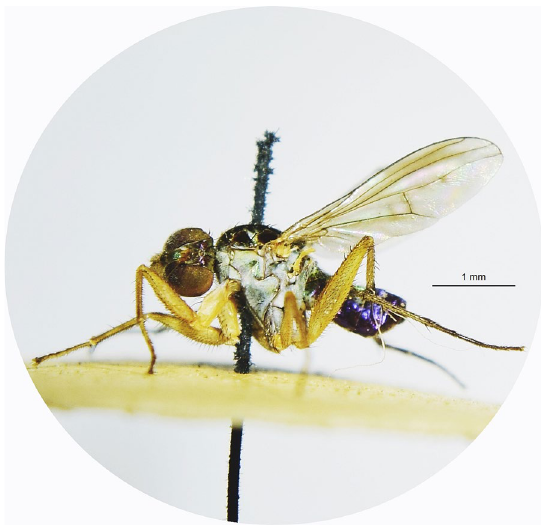
Fig. 7 Thinophilus quadrimaculatus Becker female habitus,